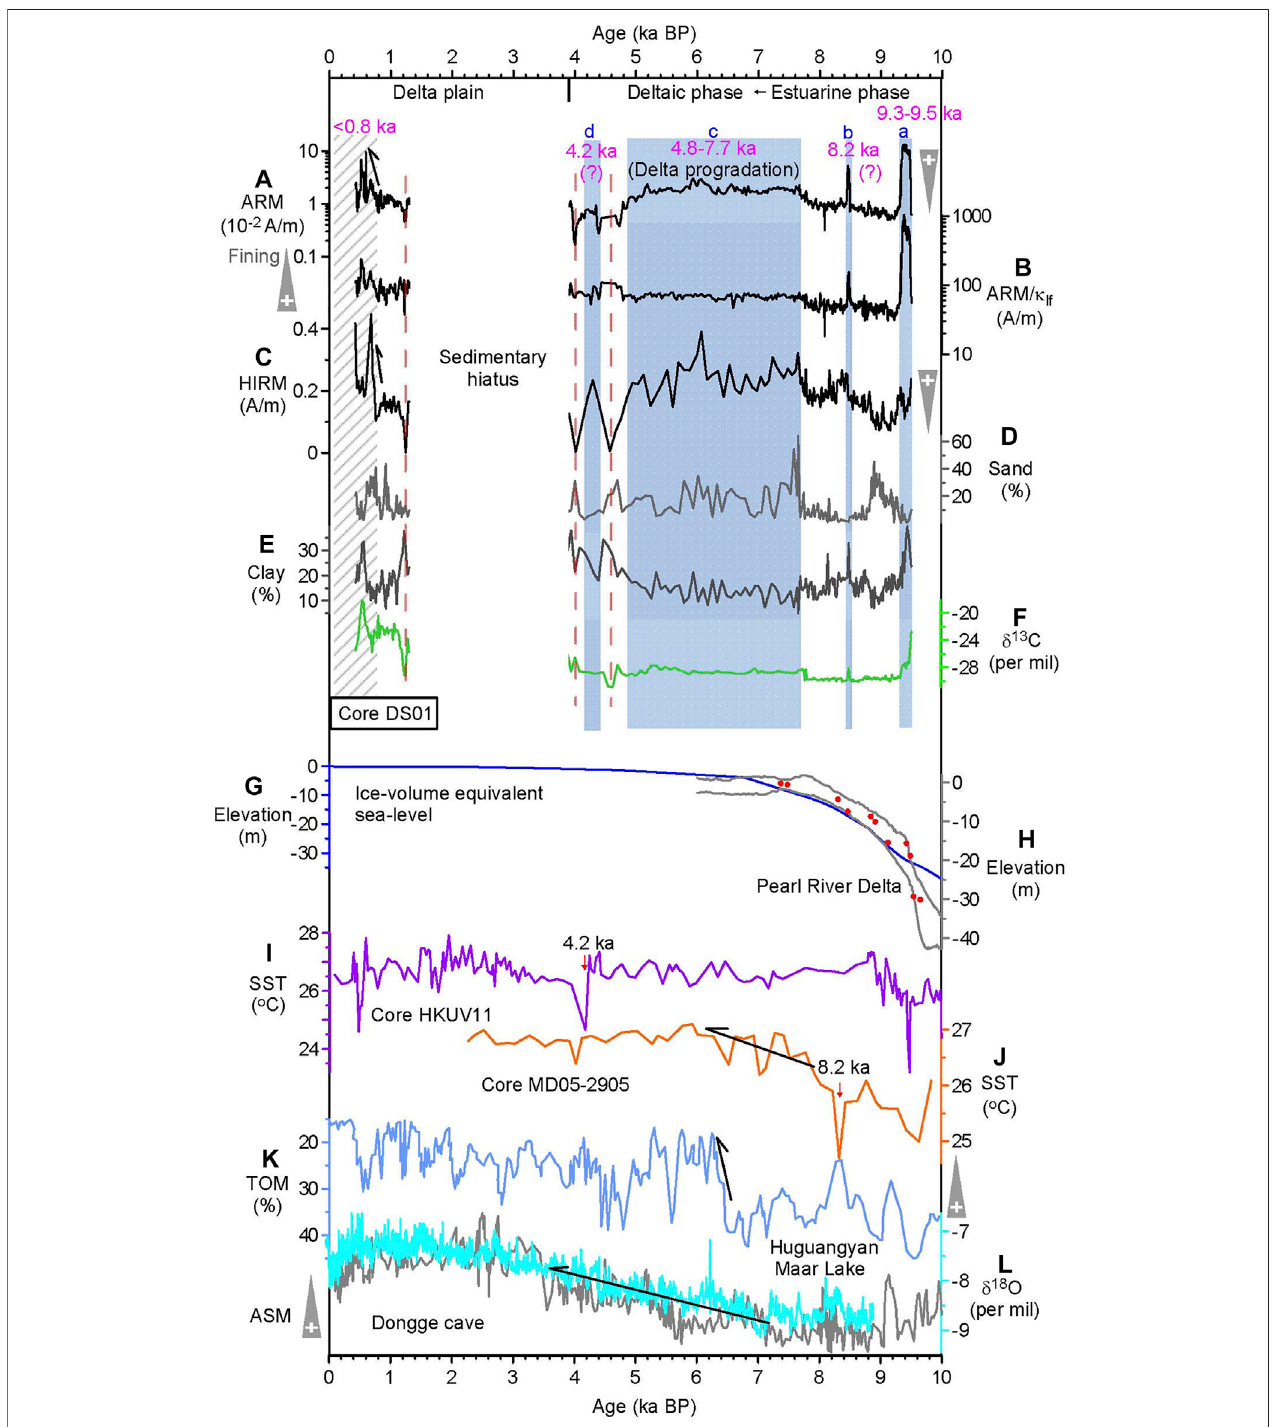
FIGURE 4 | Comparison of magnetic records for core DS01 with selected independent paleoenvironmental records. (A – C) ARM, ARM/ κ lf , and HIRM (this study); (D – F) sand content, clay content, and carbon isotope ratios ( δ 13 C) from core DS01 (Fu et al., 2020); (G) elevations of ice-volume equivalent sea-level (Lambeck et al., 2014); (H) elevations from the mean sea level during 6 – 10 kyr BP, after correction for regional tectonic subsidence and sedimentary compaction [redrawn from Xiong et al. (2018)]; (I , J) sea surface temperature reconstructions from core HKUV11 (Wu et al., 2017) and core MD05-2905 (Zhou et al., 2012), respectively; (K) total organic matter (TOM) record from Huguangyan Maar Lake (Wang et al., 2016); and (L) the speleothem oxygen isotope record ( δ 18 O from Dongge Cave, an indicator of Asian summer monsoon intensity, ASM) (~0 – 9 kyr BP, cyan curve (Wang et al., 2005); 0 – 10 kyr BP, gray curve (Dykoski et al., 2005). In (H) , red circles represent correctedelevations(withoutrange)fromdrillingcoresfromthePearlRiverDeltaheadareaandestuarinearea,whilethe(upperandlower)graycurvesrepresentthe99% probability envelope of the reconstructed sea-level changes across the Pearl River Delta.